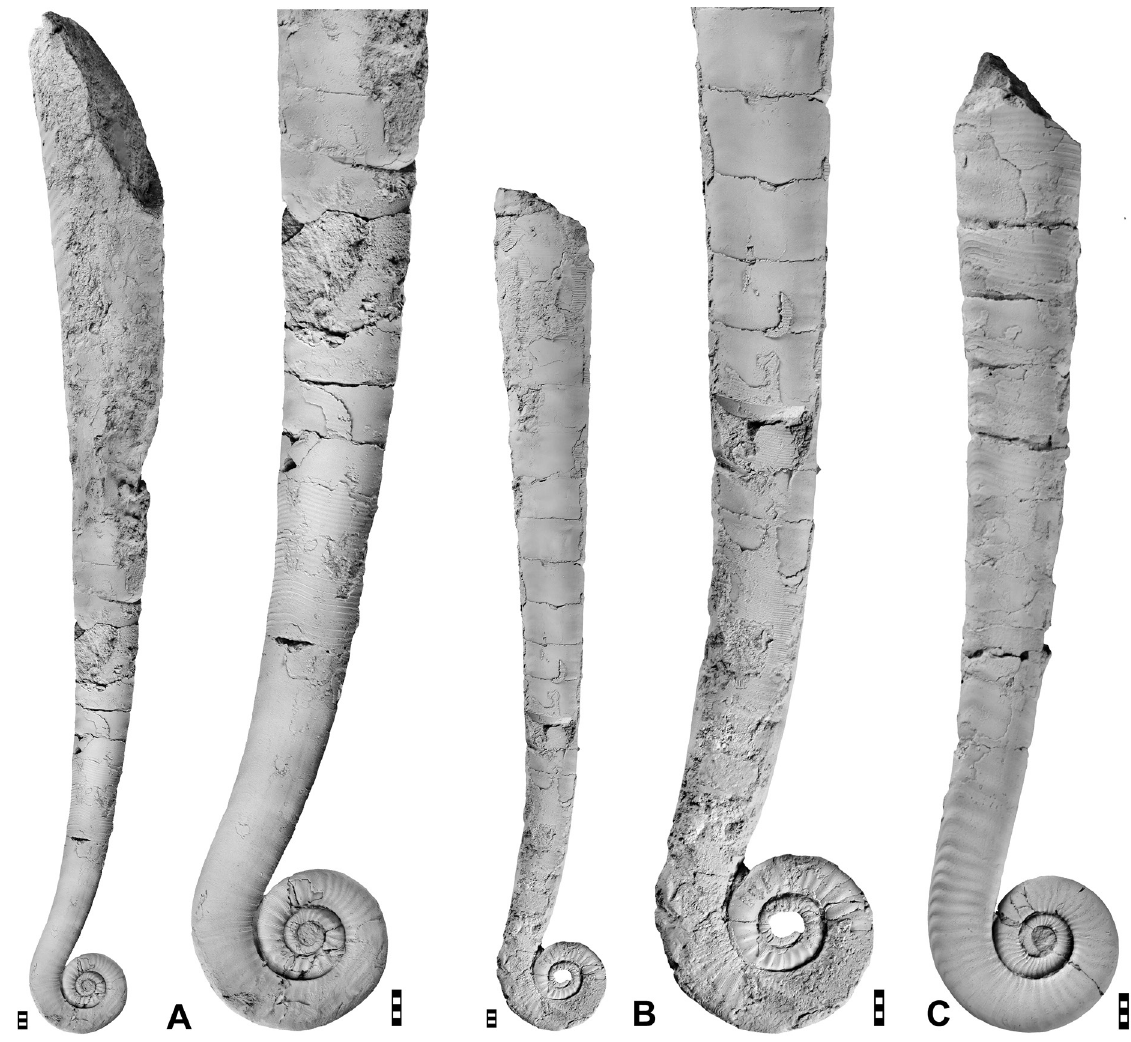
Fig. 33. Lituites lituus de Montfort, 1808 (A–B) and Lituites cf. lituus de Montfort, 1808 (C) from the Upper Grey Orthoceratite Limestone. A . Neotype MB.C.30527 (Neben & Krueger Coll.) from Oderberg, Bralitz (Brandenburg); previously figured by Neben & Krueger (1971: pl. 31 fig. 1); magnification of the coiled part on the right. B . Specimen MB.C.2497 (Helms 1966 Coll.) from Groß Zicker (Island of Rügen, Mecklenburg-Vorpommern); magnification of the coiled part on the right. C . Specimen MB.C.30529 (Münchner Coll.) from the Island of Chrząszczewska (former Gristow), West Pomerania, Poland. Scale bar units = 1